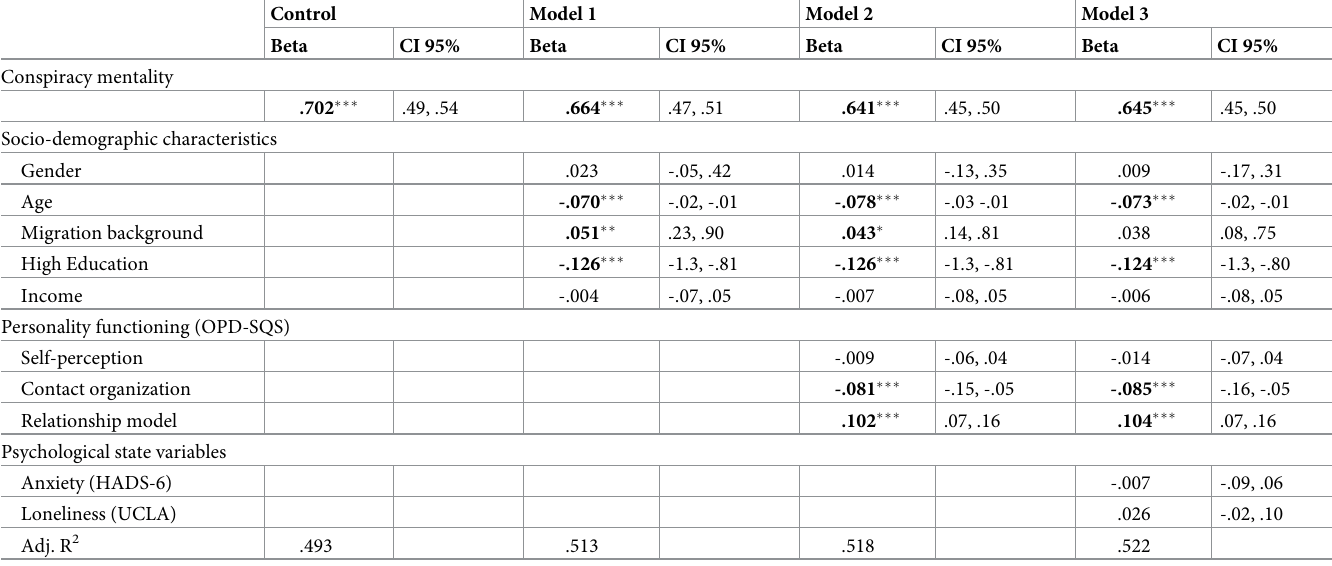
Table 4. Linear regression analyses of conspiracy-related beliefs toward COVID-19 on conspiracy mentality, socio-demographic characteristics, personality func- tioning, and psychological state variables.